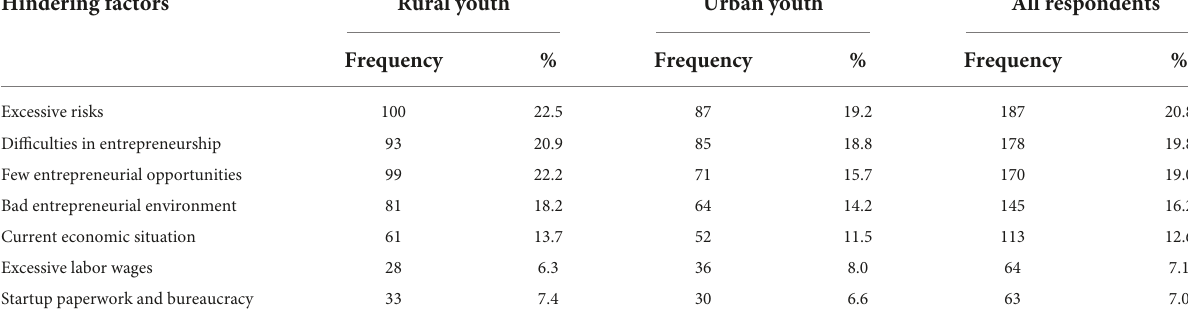
TABLE 6 Entrepreneurial environment. Hindering